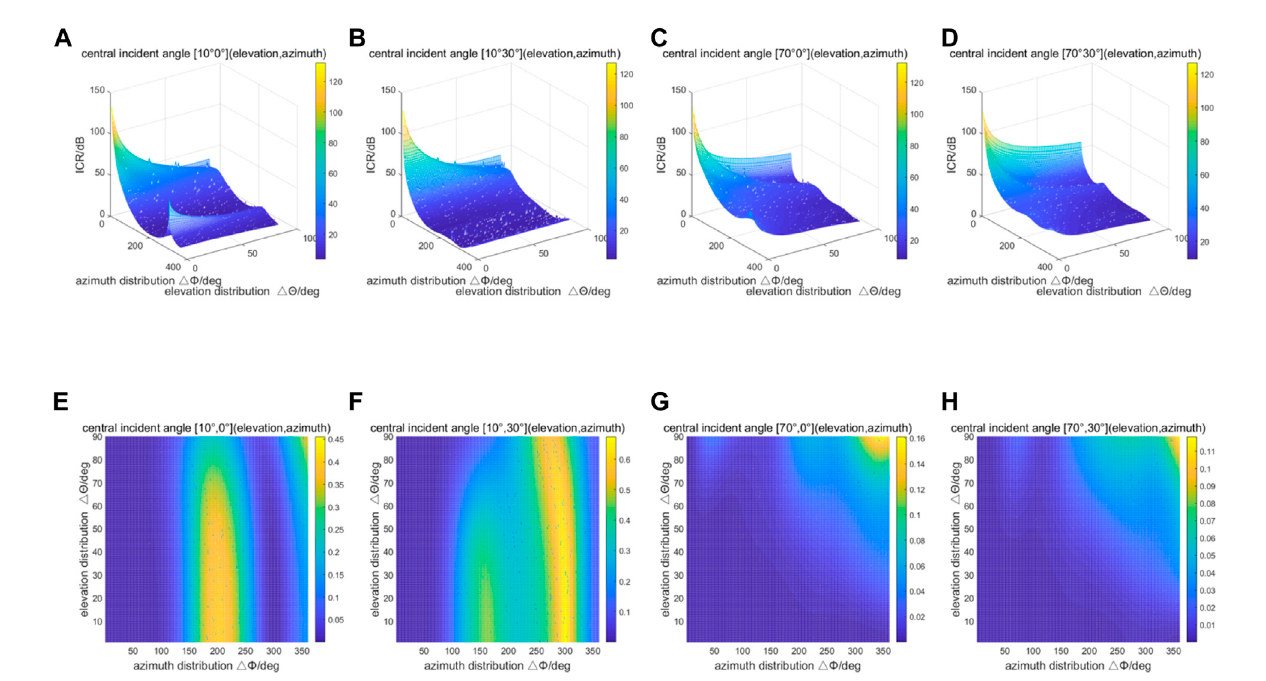
FIGURE 8 Anti-jamming performance against central incident direction and interference distribution. (A) ICR at central incident angle of [10 ° , 0 ° ]; (B) ICR at central incident angle [10 ° ,30 ° ]; (C) ICR at central incident angle [70 ° ,0 ° ]; (D) ICR at central incident angle [70 ° ,30 ° ]; (E) Optimal residual interference power at central incidentangleof[10 ° ,0 ° ]; (F) Optimalresidualinterferencepoweratcentralincidentangle[10 ° ,30 ° ]; (G) Optimalresidualinterferencepoweratcentralincident angle [70 ° ,0 ° ]; (H) Optimal residual interference power at central incident angle [70 ° ,30 ° ].